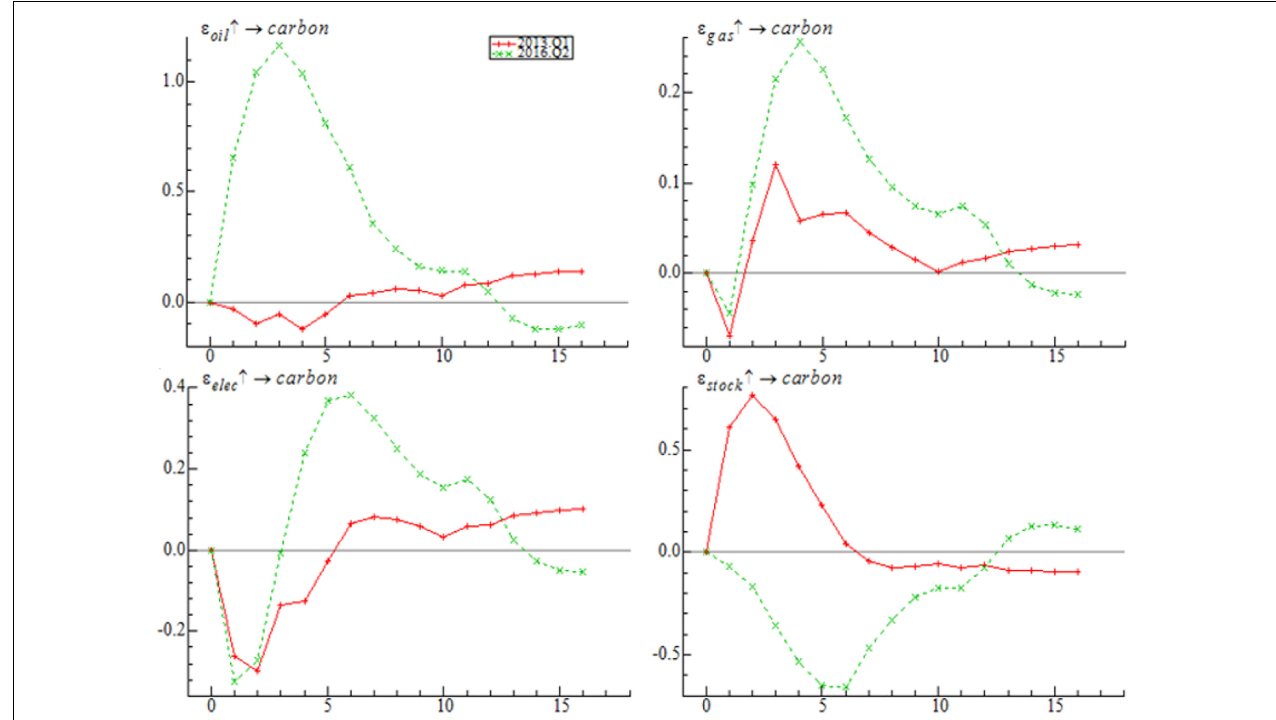
FIGURE 5 | Time-point impulse graph of the impacts of carbon price on key price